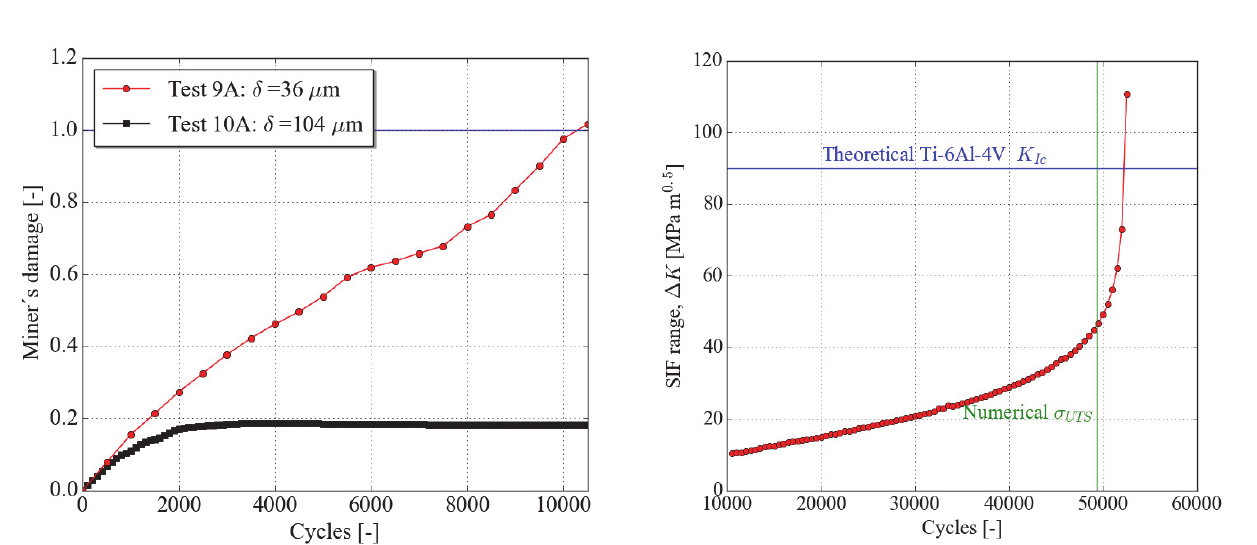
Figure 8: Left side: Detailed view of the Miner’s damage evolution to crack initiation. Right side: Estimated SIF range vs. cycles in propagation.